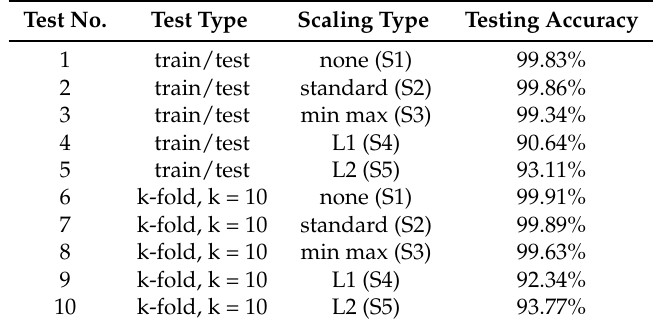
Table 5. Classification accuracy of M1 (Logistic Regression) on BUZZ1 train/test dataset.